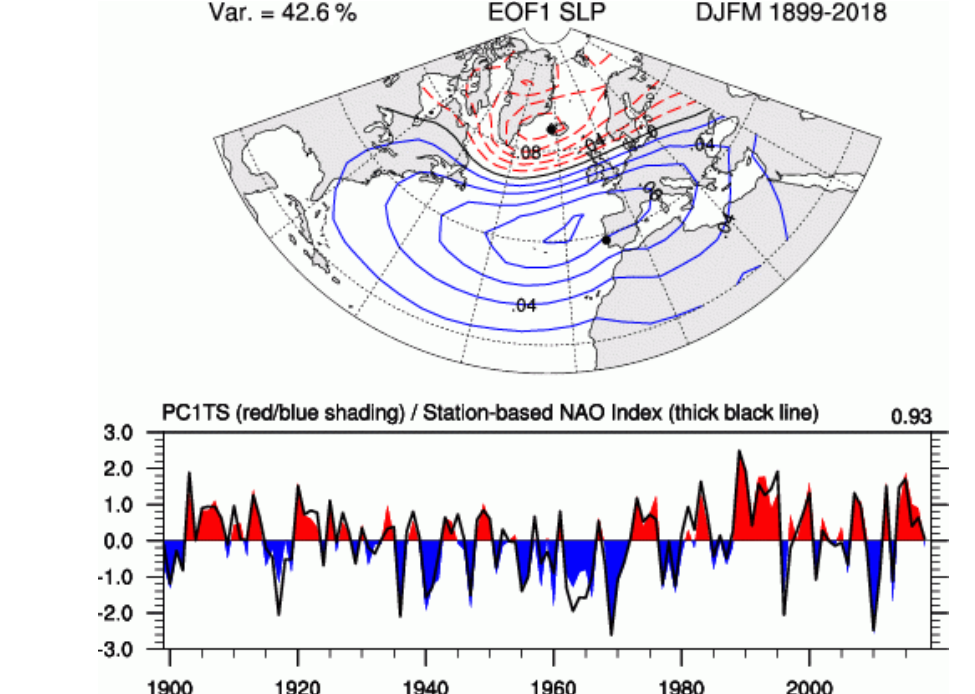
Figure 2. The top panel shows the principal component (PC) time series of the leading EOF (empirical orthogonal function) of seasonal (December–January–February–March) SLP (sea level pressure) anomalies over the Atlantic sector (20–80 ◦ N, 90 ◦ W–40 ◦ E) for 1899–2018 (colours), and the bottom panel shows the station-based (Lisbon and Stykkishólmur) index (black line, see points on map). The correlation is 0.93 over the 1899–2018 period. The figure is sourced from Hurrell